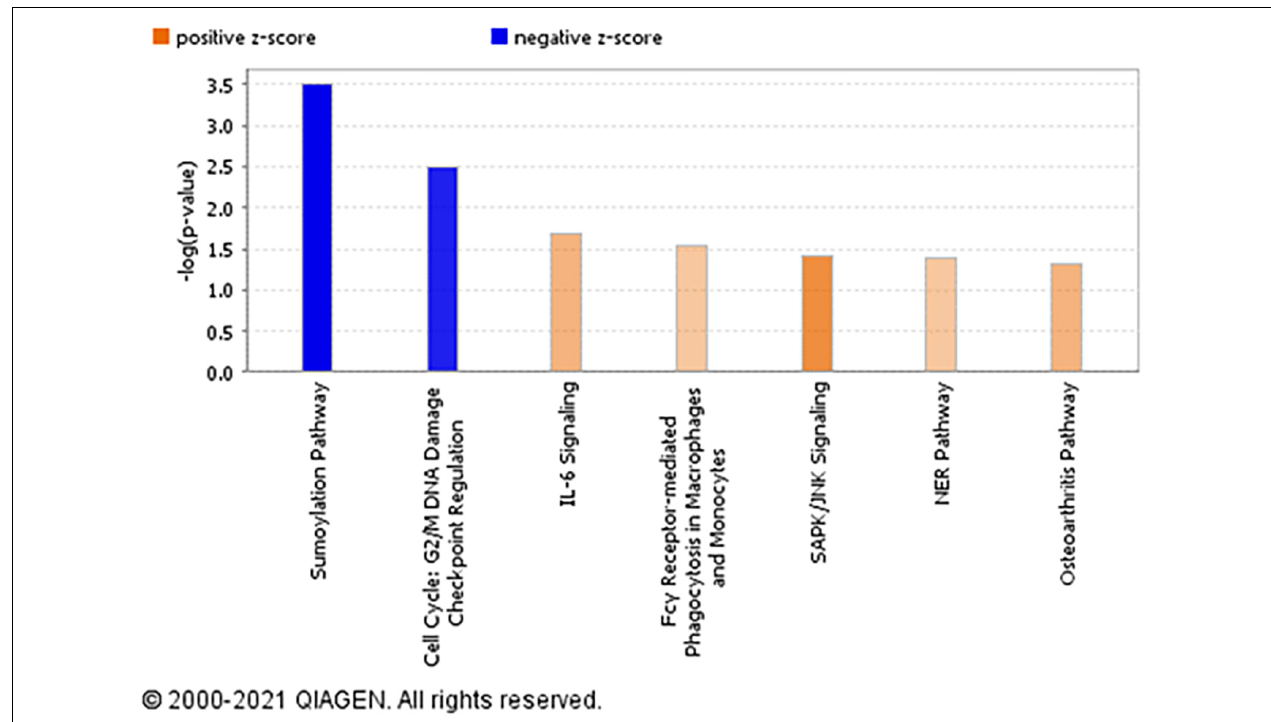
FIGURE 3 | Overall functional analysis. Analysis of the top molecular and cellular functions determined by IPA for the rictor siRNA silenced (mTORC2 inhibited) PHT cells. Ingenuity Pathway Analyses (IPA) of array data identified canonical pathways significantly affected by rictor silencing in PHT cells. Color index represents pathway expression changes, the orange represents up-regulated pathways, and the blue represent down-regulated pathways in rictor silenced PHT cells as compared to cells transfected with scramble siRNA.